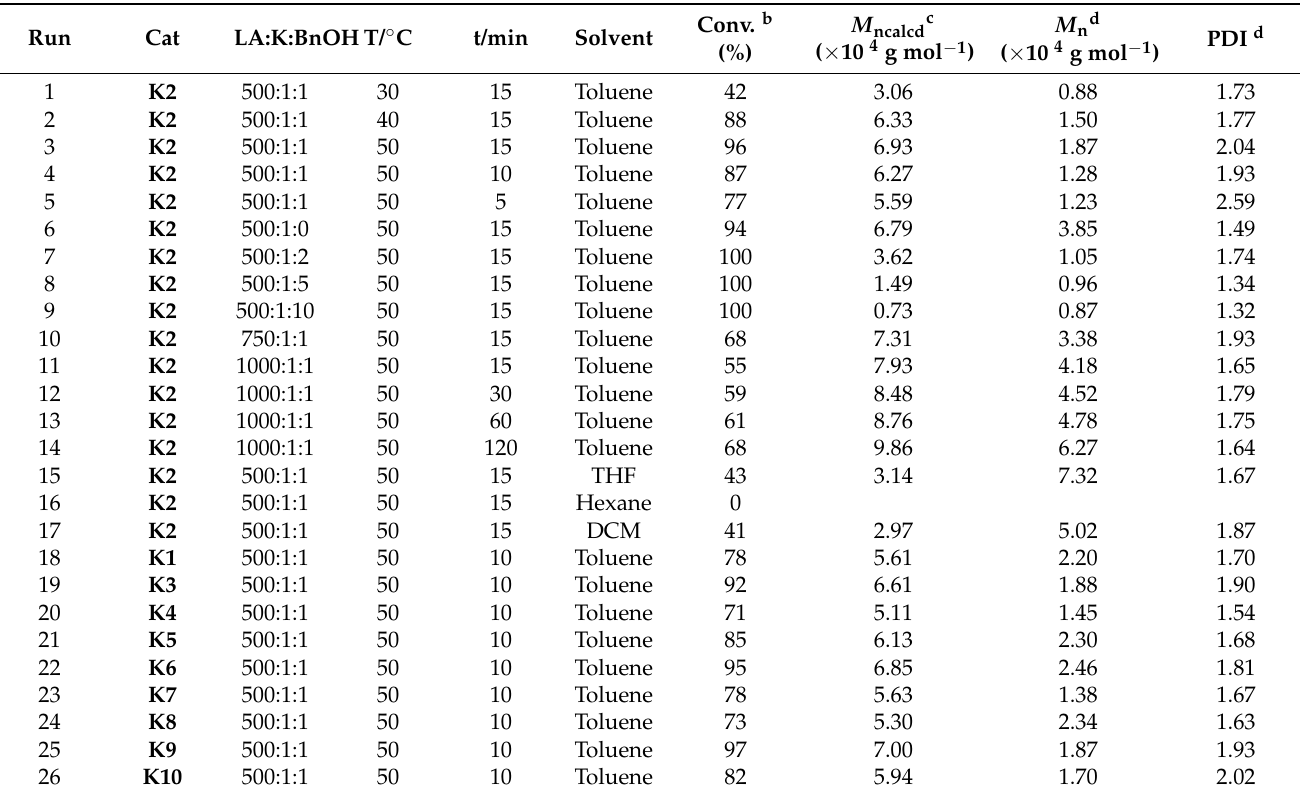
Table 2. Ring-Opening polymerization of L-lactide by K1 – K10 a